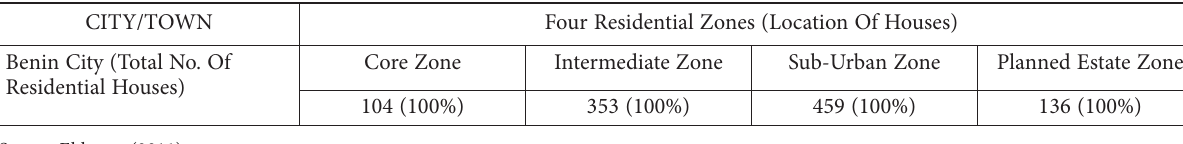
Table 1. Numbers of selected residential houses in the four zone of Benin CITY/TOWN Four Residential Zones (Location Of Houses) Benin City (Total No. Of Residential